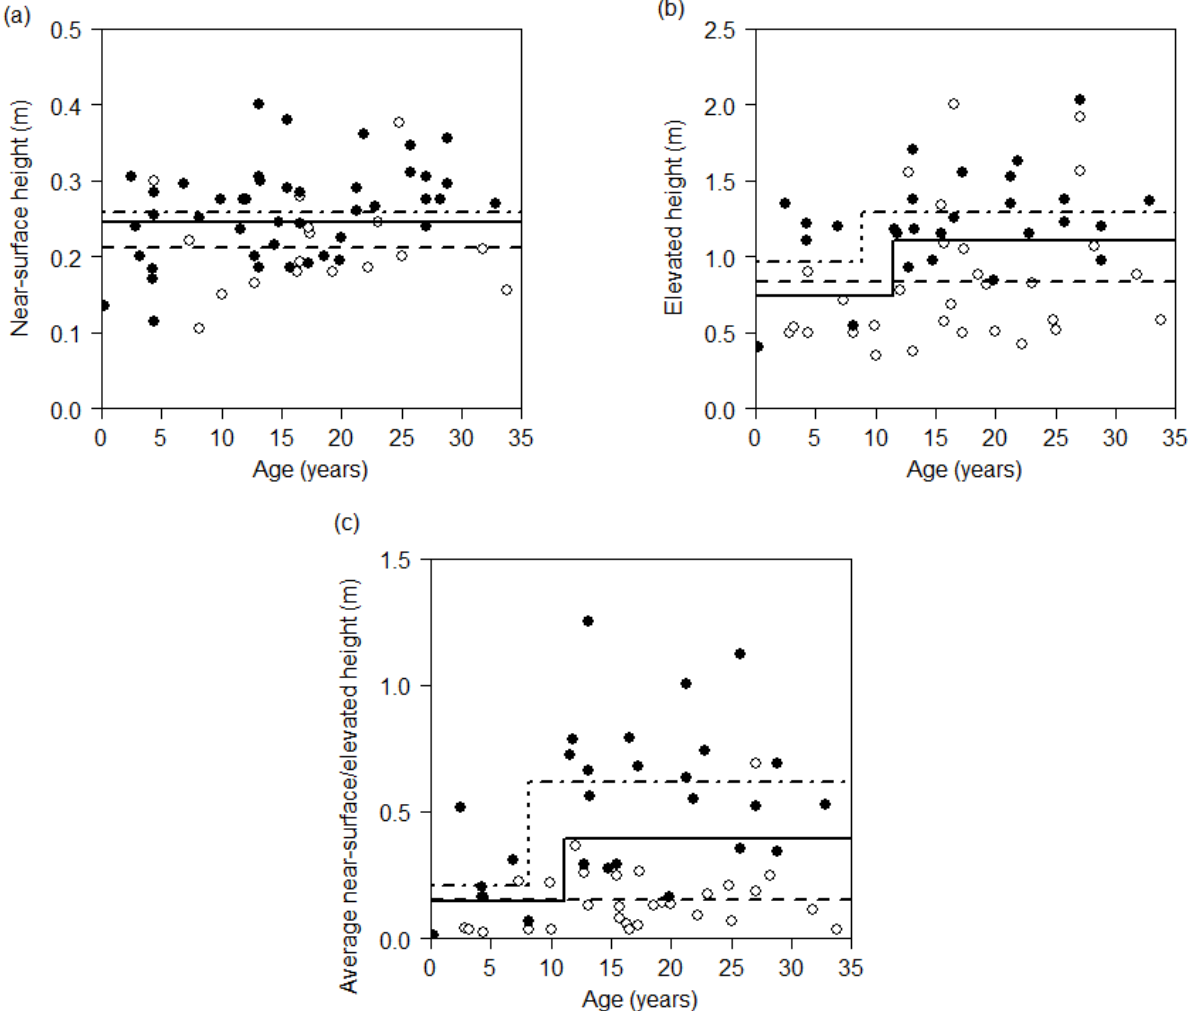
Figure 7. Step models for near-surface, elevated fuel height, and average near-surface/elevated height overlaying the data and split by understorey. ( a ) Near-surface height: litter—white circles and dashed line; grassy/bracken/heathy—black circles and dotted-dashed line, overall model—solid line. ( b ) Elevated height: litter/grassy—white circles and dashed line; bracken/heathy—black circles and dotted-dashed line, overall model—solid line. ( c ) Average near-surface/elevated height: litter/grassy—white circles and dashed line; bracken/heathy—black circles and dotted-dashed line, overall model—solid line.